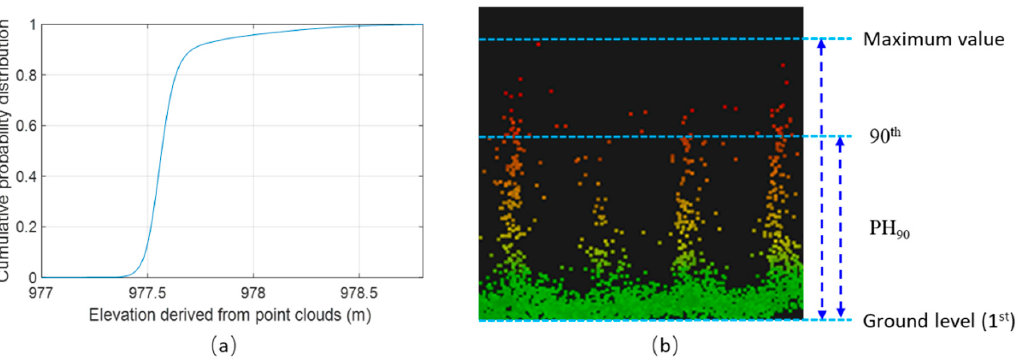
Figure 4. Schematic indicating the selecting method of the six maize plant height features (PH 90 , PH 95 , PH 97 , PH 98 , PH 99 , and PH max ) for each sampling plot. ( a ) The curve of the cumulative probability distribution of point clouds within each sampling plot; ( b ) a cross-section view of point clouds within a sampling plot illustrating the calculation of plant height using height percentiles.